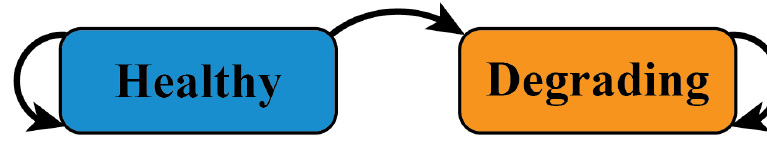
Figure 6. Hidden Markov model